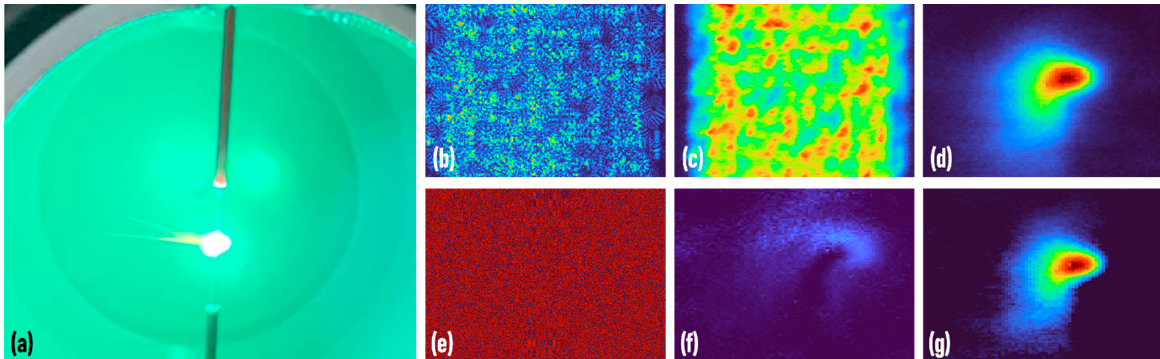
Figure 9. ( a ) Direct imaging of the spark. Images of the ( b ) PSH, ( c ) object hologram ( d ) reconstructed image using non-linear filter, ( e ) phase of the Fourier transform of the synthetic PSH, ( f ) edge, and ( g ) contrast-enhanced reconstructions.